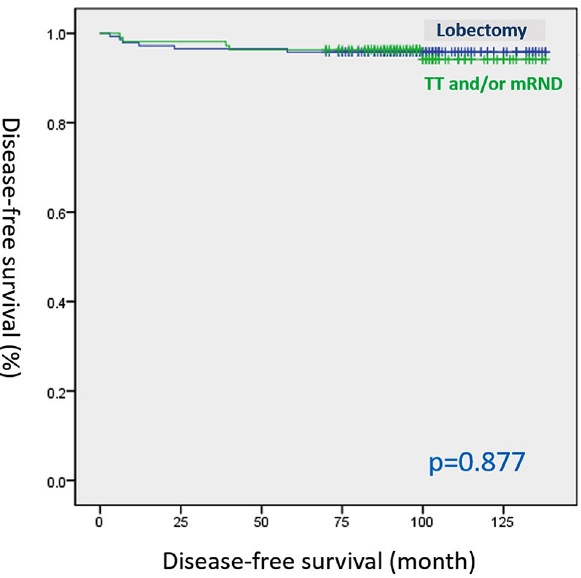
Figure 2. Disease-free survival curves according to the extent of surgery (log-rank test, p = 0.877). TT total thyroidectomy, mRND modified radical neck